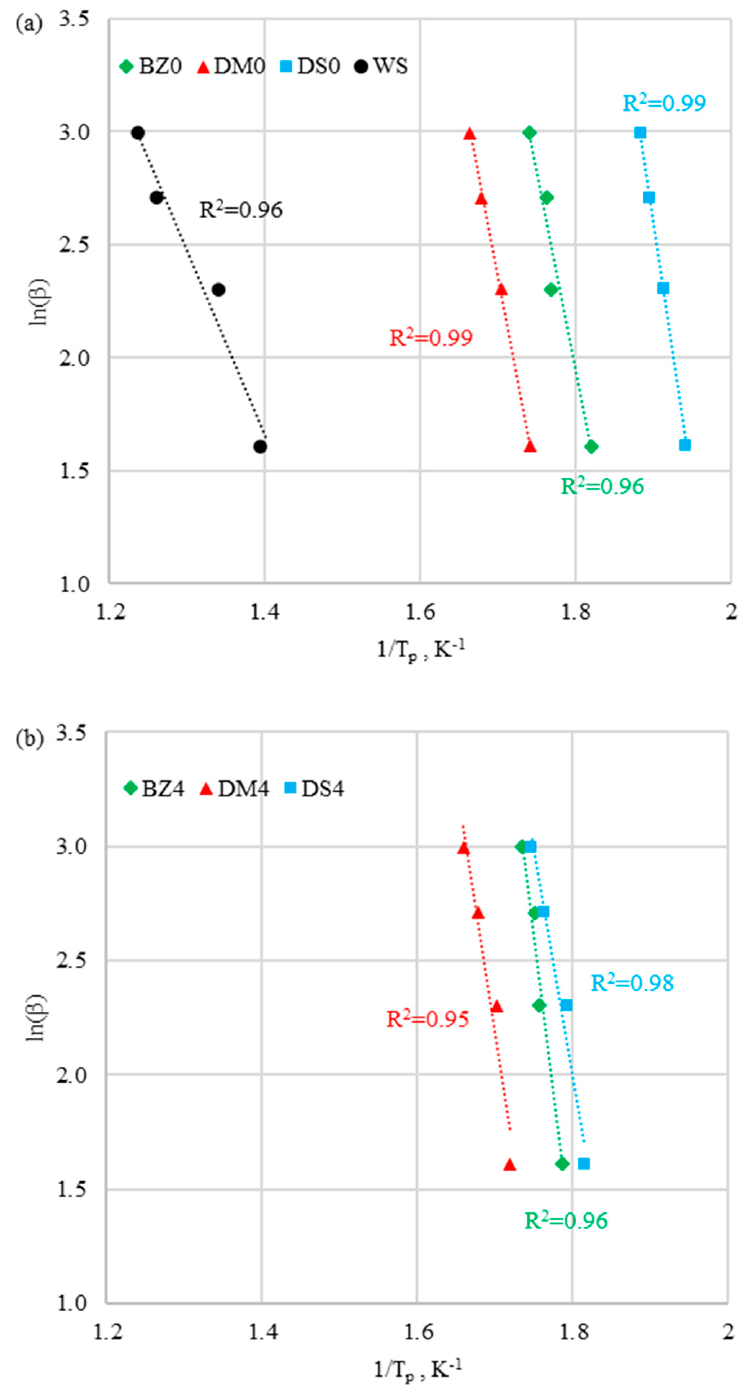
Figure 8. Activation energy calculation by Ozawa method for ( a ) fuels without halloysite and ( b ) fuels with halloysite at third peak. Table 4. Activation energy (E a ) and correlation coefficient (R 2 ) for tested fuels (I—evaporation, II—oxidation mass gain, III—thermal decomposition and burning—Figure 1).